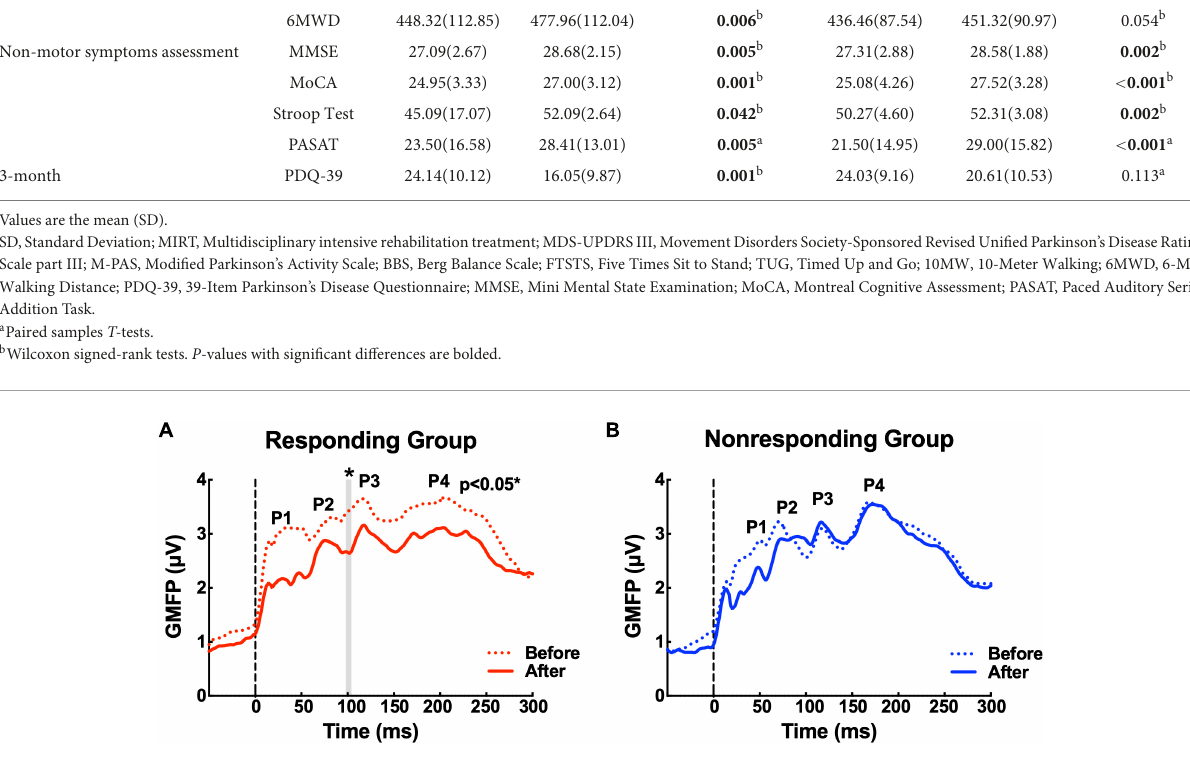
effect on motor function in PD patients (Zhu et al.,